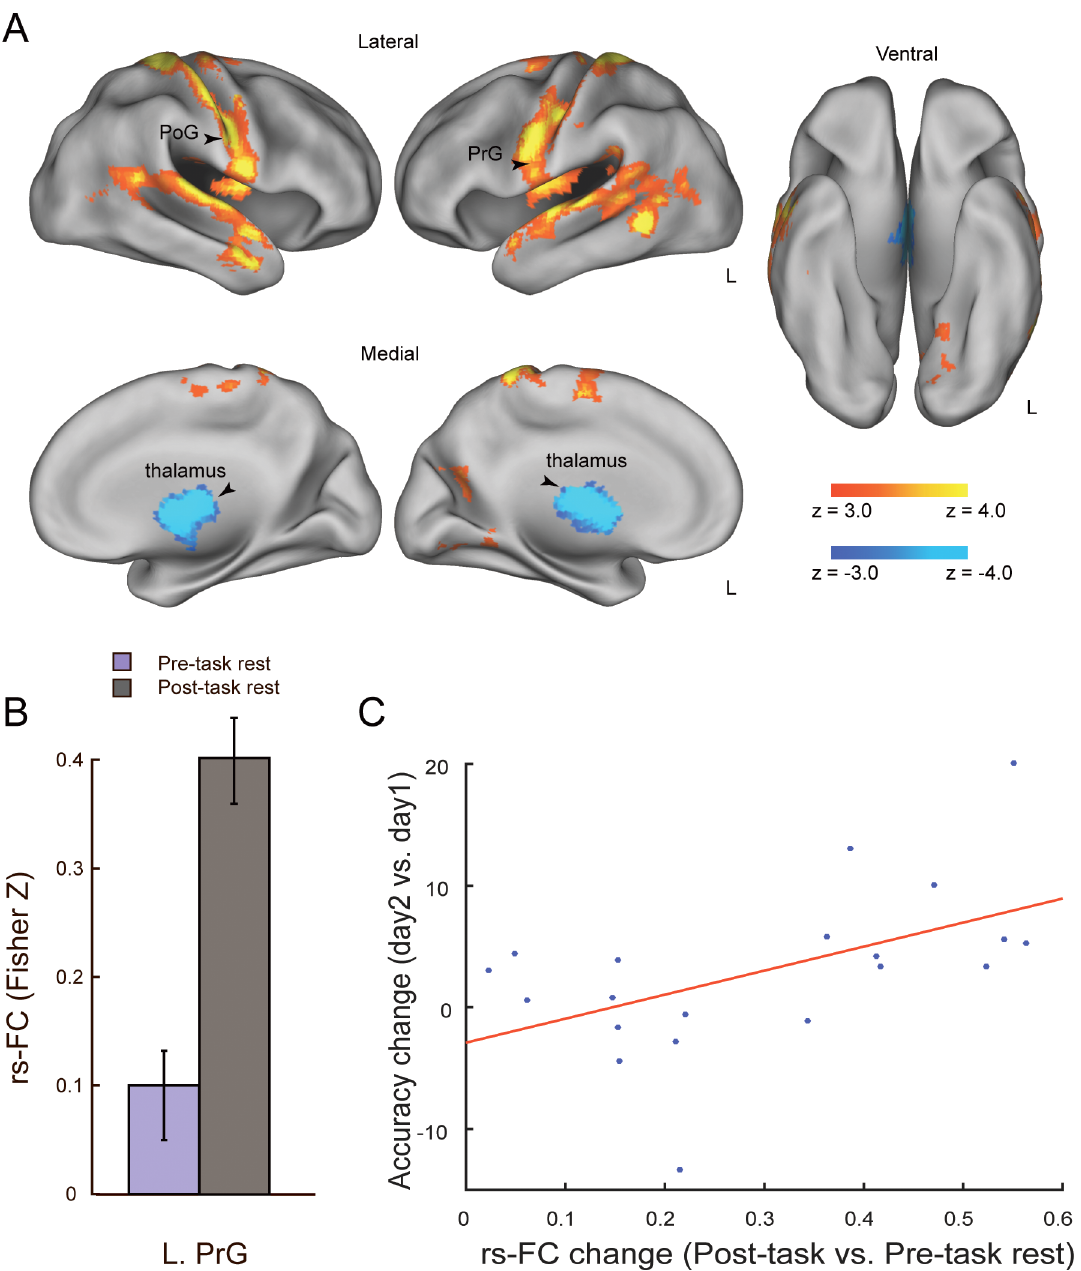
Fig 4. Training-induced rs-FC changes and brain-behavior correlation. (A) The statistical map indicates brain regions showing training-induced rs-FC changes with the MT+ seed (hot: Post-task > Pre-task rest, cold: Pre-task > Post-task rest). The arrow head indicates the left PrG. All maps are thresholded at P < 0.05, cluster-level FWE corrected across the whole brain. (B) Pre-task and post- task rs-FC between the MT+ and left PrG. The y axis indicates the correlations (Fisher Z transformed) between the time series extracted from the MT+ and left PrG, averaged across participants. The error bars indicate s.e.m. The bar graph is provided for visualisation purposes, and no statistical test was applied to this data. (C) Scatter plot showing individual differences in behavioural improvement (accuracy gain on day 2 relative to day 1) as a function of training-induced rs-FC change between the MT+ and left PrG. PoG: postcentral gyrus; PrG: precentral